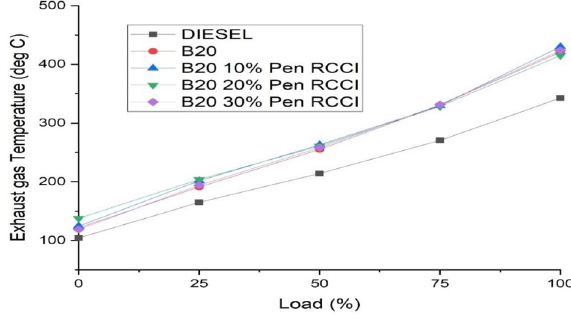
Figure 6. Exhaust gas temperature versus load.